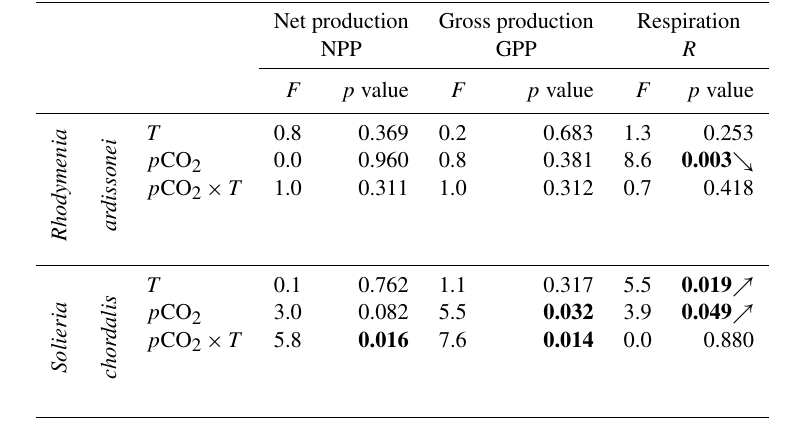
Table 7. Summary of the effects of p CO 2 and temperature ( T ) and their combined effect on gross production and respiration of the two epiphytic algae R. ardissonei and S. chordalis in the summer ( n = 5). Statistical analyses were performed using a two-way crossed Scheirer– Ray–Hare test. Significant p values are presented in bold ( α = 0.05). Degrees of freedom = 1.